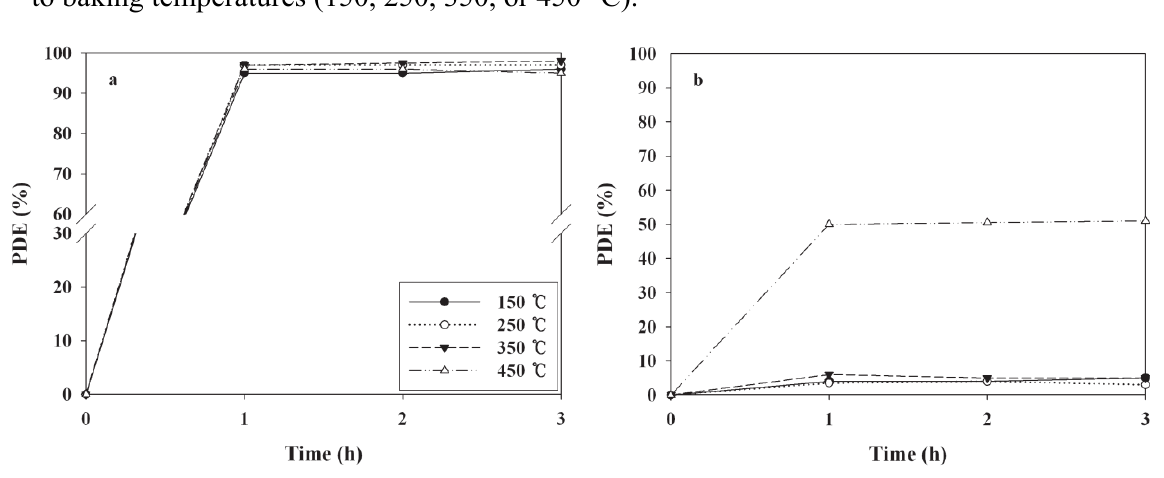
Figure 1. Time-series photocatalytic efficiencies (PDEs, %) of 2-propanol and gas-phase trichloroethylene (TCE) as determined at the outlet of the photocatalytic reactor, according to baking temperatures (150, 250, 350, or 450 °C).